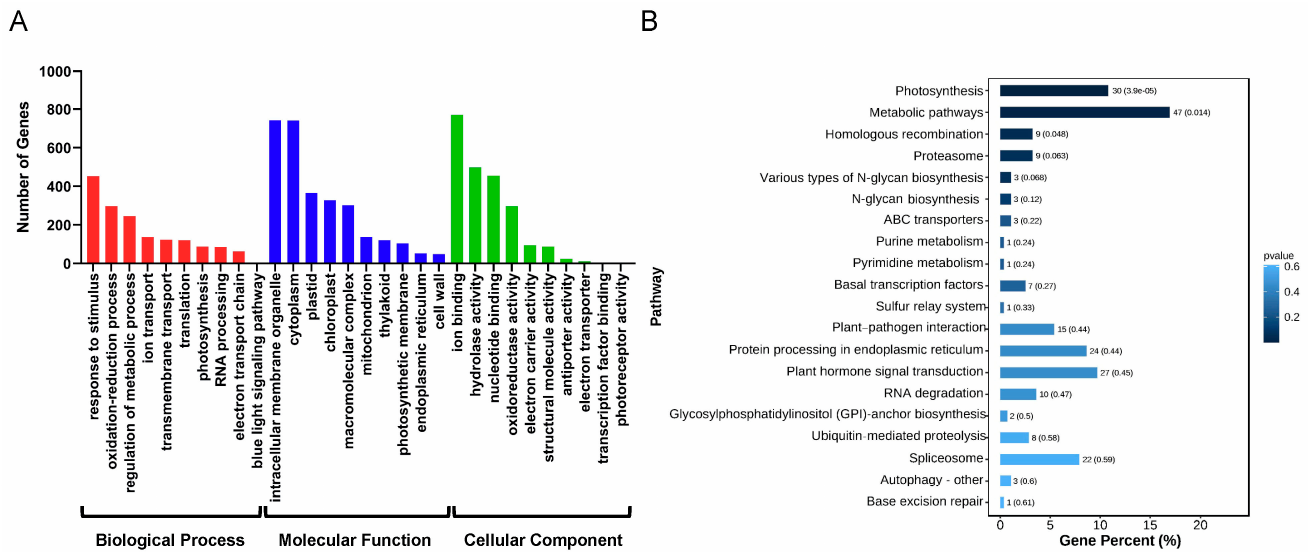
Figure 3. Functional analysis of cis-regulated lncRNA–mRNA pairs. ( A ) GO term classification of targets. The x -axis indicates GO terms, and y -axis indicates the number of genes. The red bar charts represent the biological process, the blue bar charts indicate the molecular function, and the green bar charts represent the cellular component. ( B ) KEGG pathways analysis of targets (top 20). The x - axis represents the percentage of genes, and the y -axis indicates the pathways.